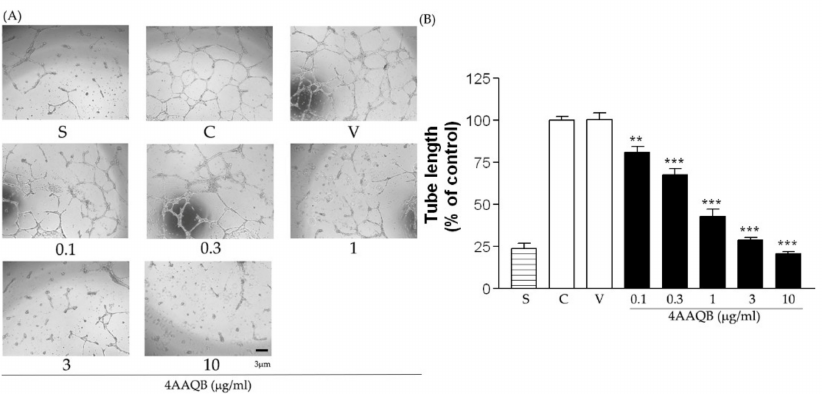
Figure 5. The effects of 4AAQB on HUVEC Matrigel tube formation. HUVEC treated with VEGF, with the vehicle (V), or various concentrations of 4AAQB were photographed ( A ), and the tube length were quantitatively analyzed as the fold change relative to the control group ( B ). Data are represented as means ± SEM ( n = 6). ** p < 0.01 and *** p < 0.001 compared with the control (C) group.